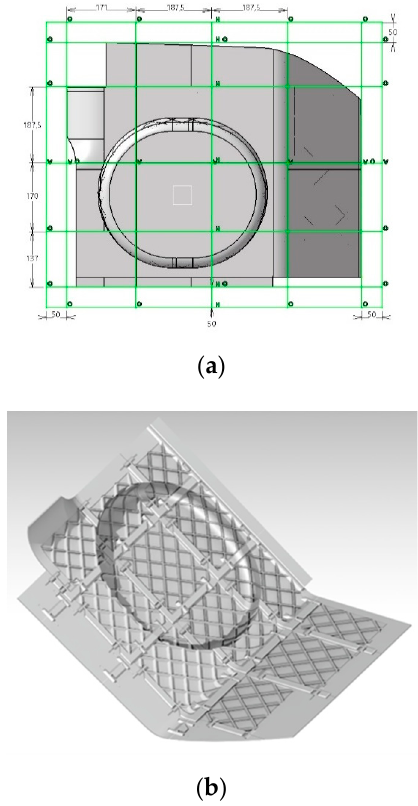
Figure 22. ( a ) Cut line arrangement for segmentation; ( b ) Rendering of the final part after application of the method in form of an assembly.